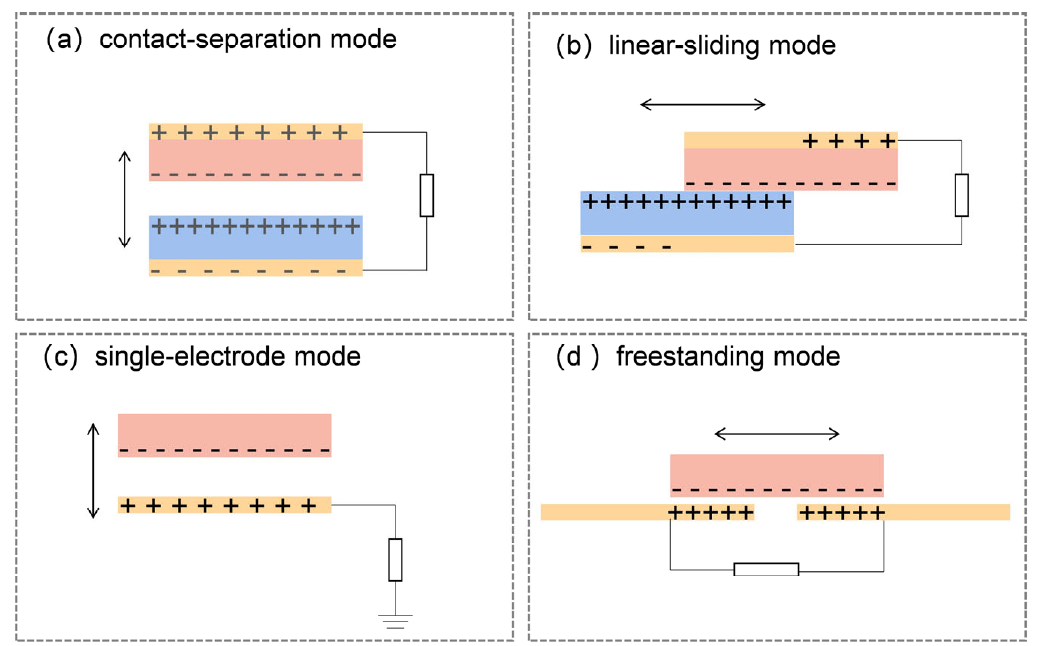
Figure 2. Four working modes of TENG: ( a ) vertical CS mode; ( b ) LS mode; ( c ) SE mode; ( d ) FS mode.